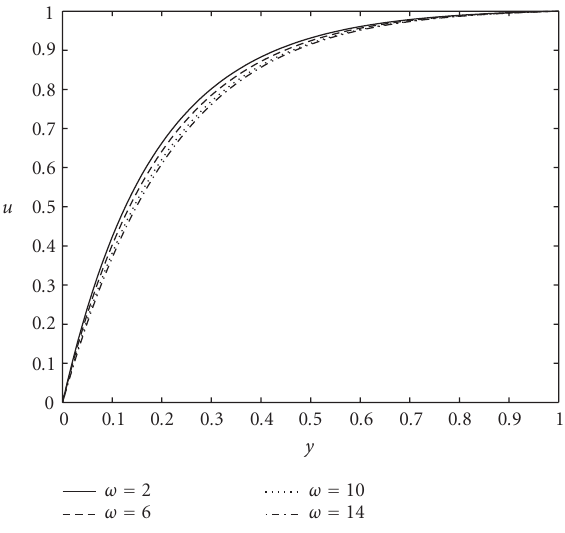
Figure 4.3. Main velocity u for S = 1 . 0, Re = 5 . 0, t = 0 . 2, z = 0 . 0, (cid:3) = 0 . 2.